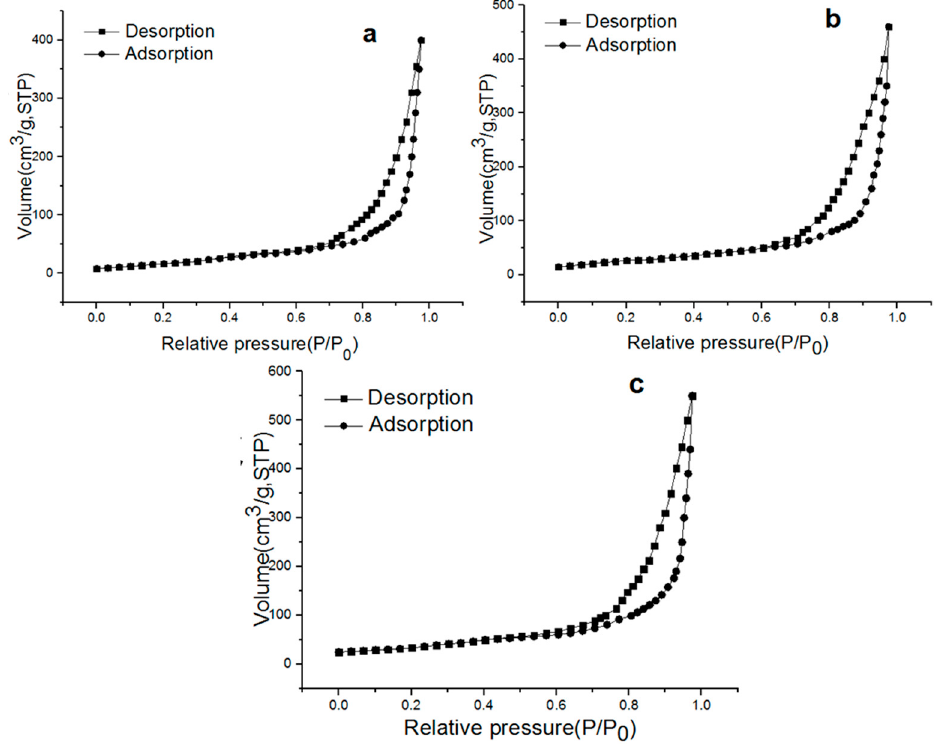
Figure 10. N 2 adsorption-desorption curves with different temperature. ( a ) 140 °C; ( b ) 150 °C; ( c ) 160 °C.